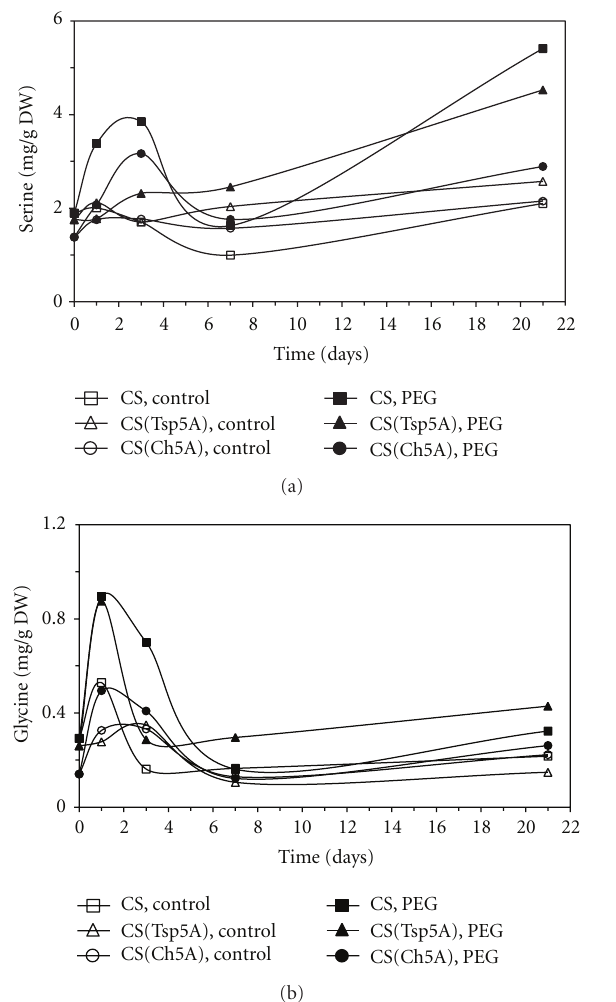
Figure 6: E ff ect of osmotic stress on the concentration of amino acids belonging to the serine family. The time course of changes was compared under control and stress (15% PEG) conditions in the freezing-sensitive CS and CS(Tsp5A) and the freezing-tolerant CS(Ch5A) wheat genotypes. The standard deviations of the data were below 10% in each case (not shown on the graphs because of the better transparency). (a): Ser (SD: 0.644), and (b): Gly (SD: 0.159).